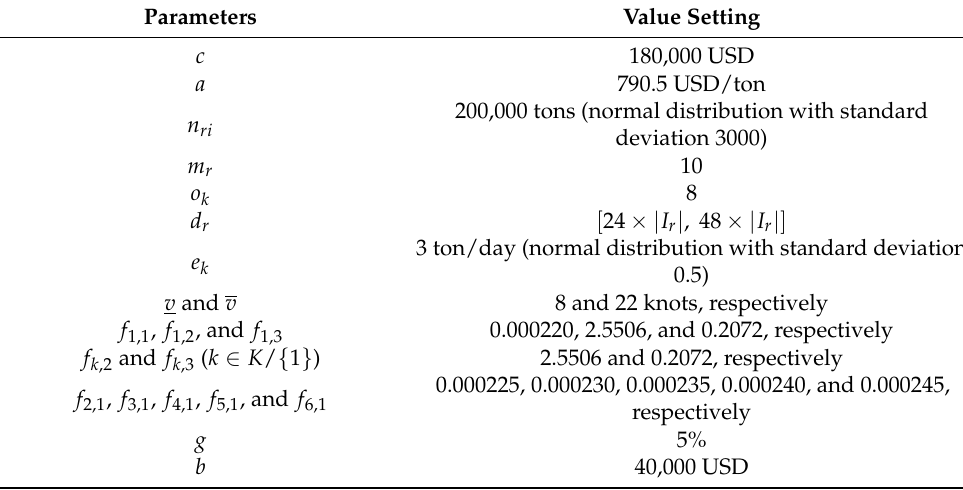
Table 1. Summary of the value setting.